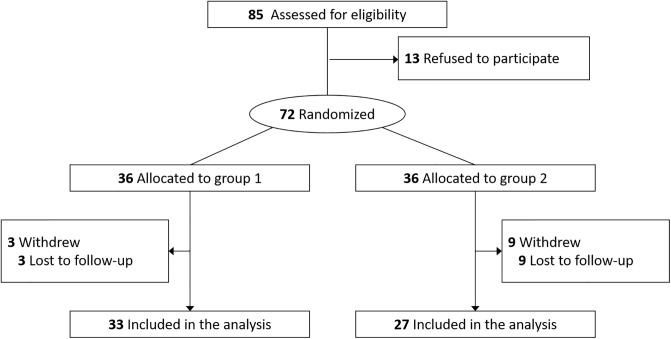
CONSORT flow diagram showing recruitment and randomization in the clinical trial.